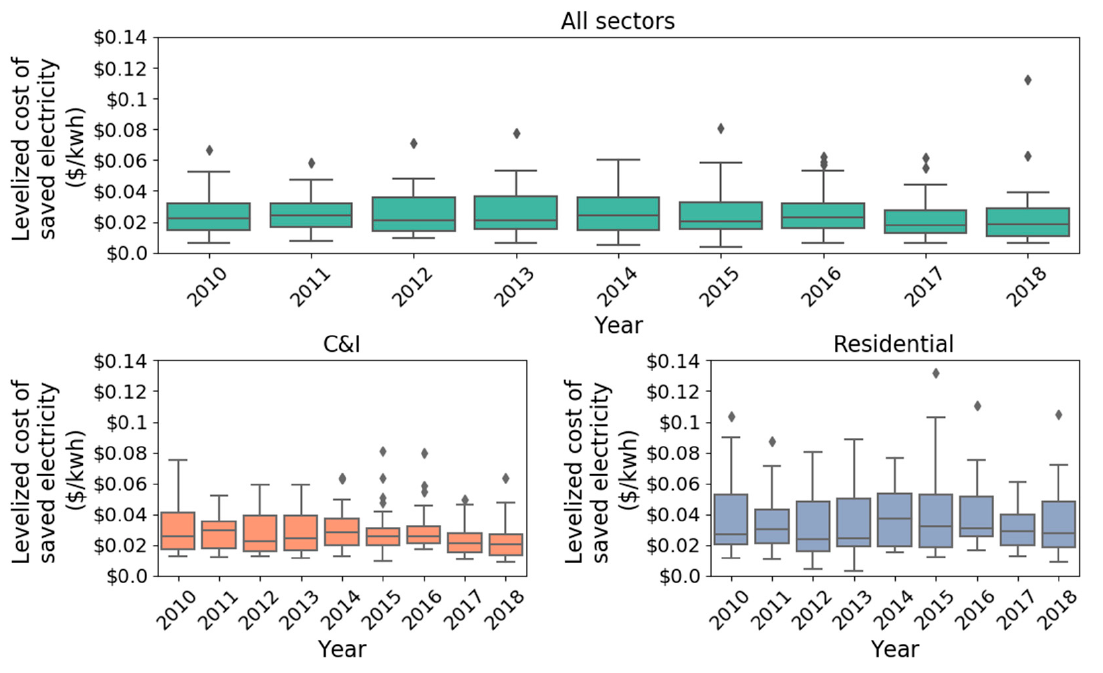
Figure 1. Portfolio-wide and sector-level cost of saved electricity 2010–2018.